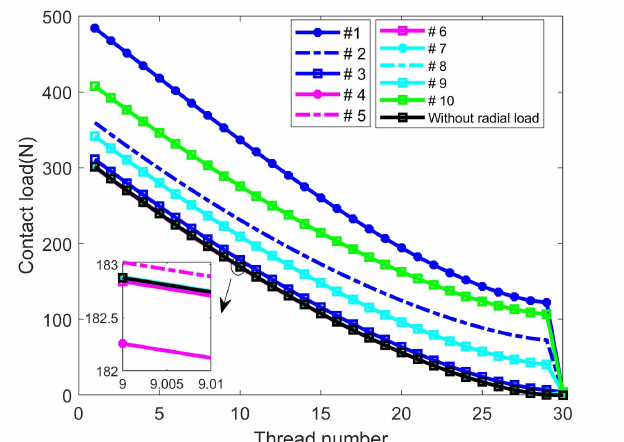
Figure 10. Contact load distribution in different threads of the robot system of case 1.